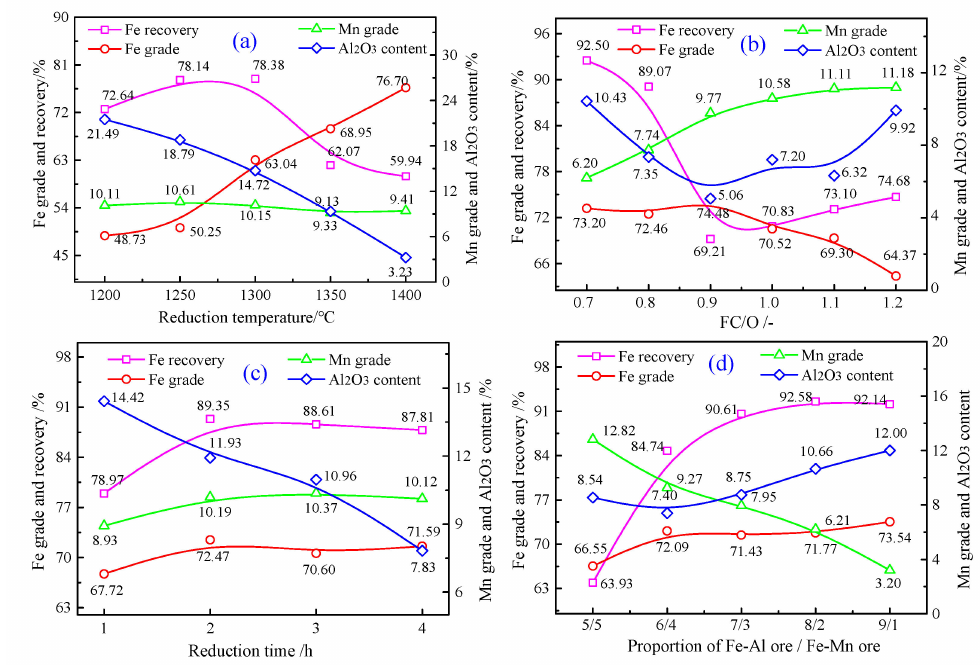
Figure 5. Effect of carbothermic co-reduction temperature ( a ), FC/O ( b ), reduction time ( c ) and proportion of Fe-Al ores/Fe-Mn ores ( d ) on separation indexes of Al, Mn and Fe from Fe-Al ores/Fe- Mn